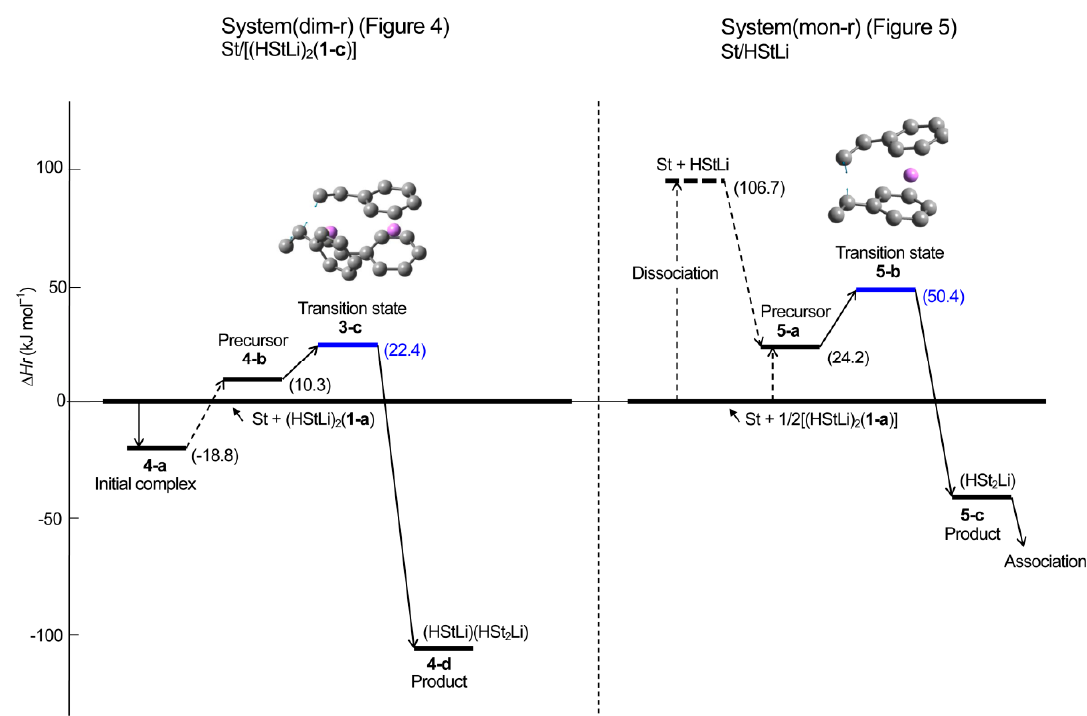
Figure 6. Enthalpy changes in the gas phase for the addition of styrene to (HStLi) 2 ( 1-c ) (system(dim-r))